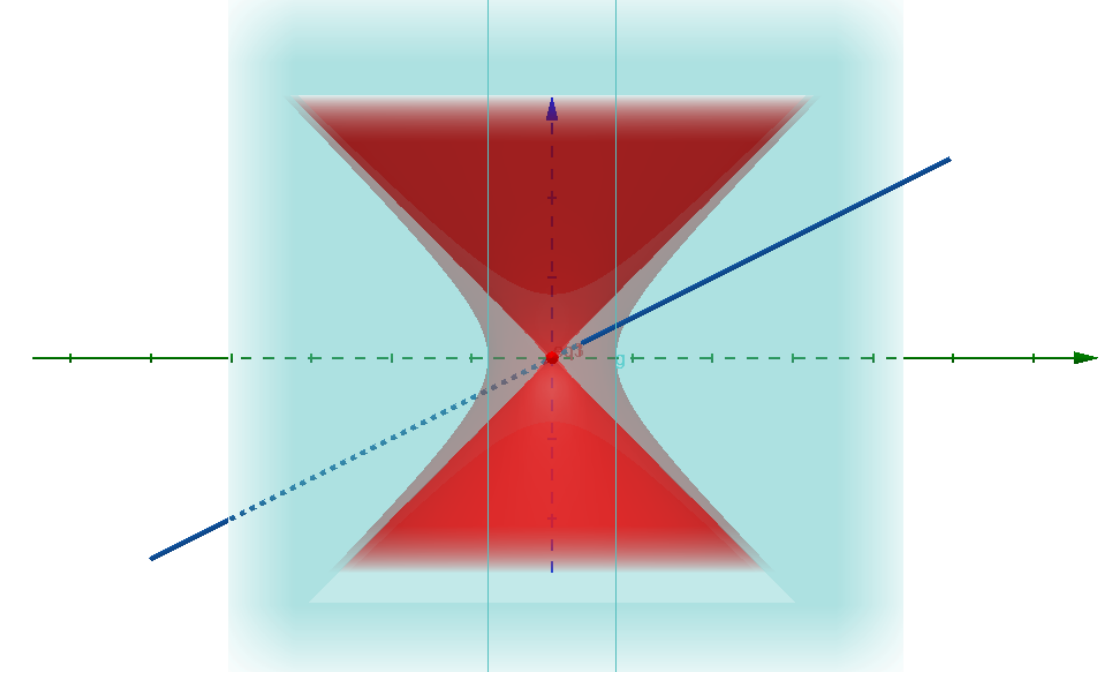
Figure 2. View of the de Sitter space along the projection line of the tangency point. The five-dimensional light-cone intersects the Minkowski space in a constant proper time hyperbola, whose two sheets are tangent to the surfaces t = ± θ . These latter constitute, together with the lines y = ± c θ represented in blue, the de Sitter horizon of the tangency point ( c θ = de Sitter